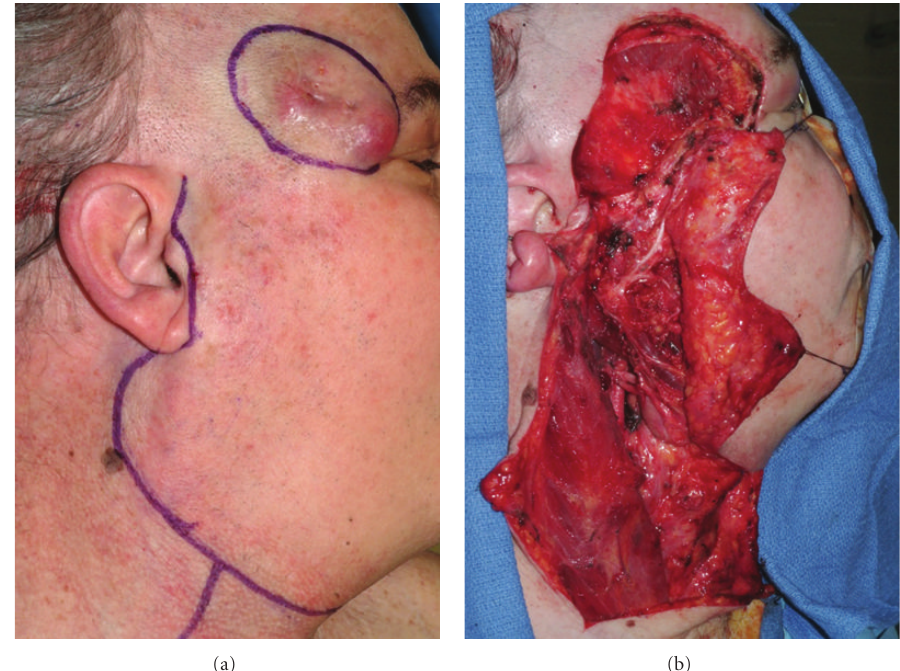
Figure 3: (a) Incision design to allow for wide local excision (1cm margins) of recurrent MCC with concomitant superficial parotidectomy, selected neck dissection, and microvascular reconstruction. (b) Completion of ablative surgery and cervical lymphadenectomy, noting distal temporal facial nerve involvement. Final pathology indicated negative margin resection. There were no cervical or parotid lymph node metastasis present on final pathologic examination.